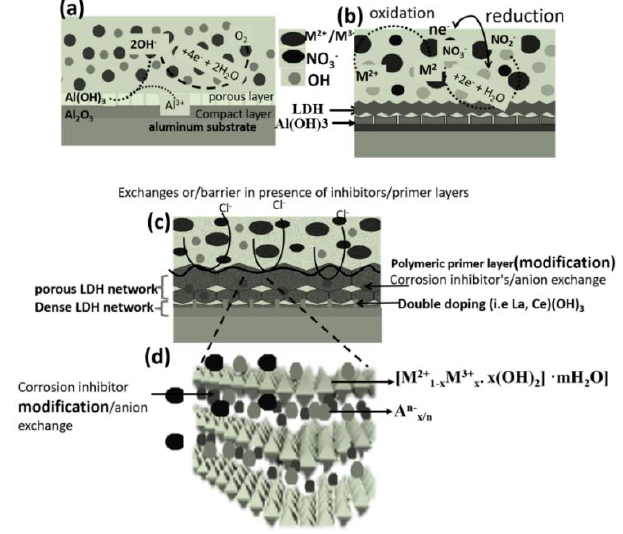
Figure 1. ( a – c ) Synthesis procedures of in situ growth LDH and possible modification approaches, ( d ) general representation of an LDH structure.